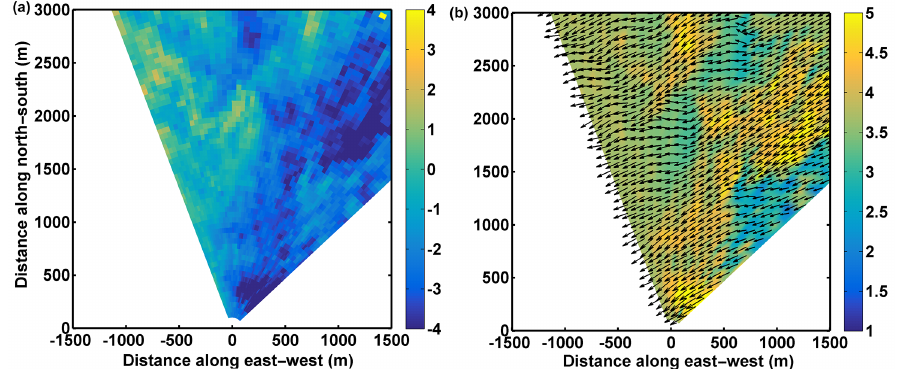
Figure 5. OI retrieval of the horizontal wind field on a PPI scan performed by D1 on 25 April, 16:52UTC. (a) LOS velocity field (in ms − 1 ) measured by D1. (b) Horizontal wind field retrieved using the OI technique. The colors indicate magnitude of horizontal wind speed (in ms − 1 ) and wind direction is indicated by arrows.